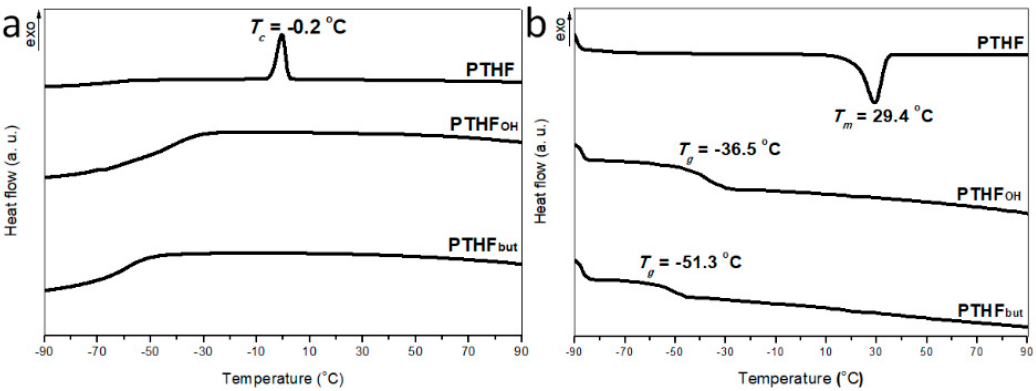
Figure 5. Differential scanning calorimeter (DSC) cooling scans ( a ) and heating scans ( b ) at 5 °C min − 1 after melting at 90 °C for the indicated polymers.